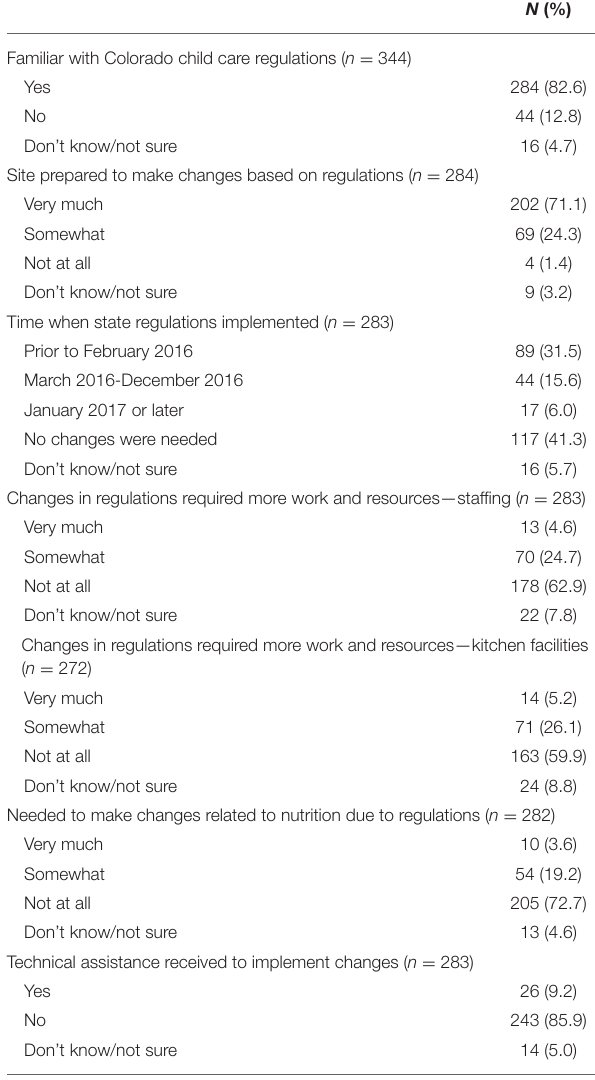
TABLE 4 | Self-reported adherence to regulations related to beverages served in Colorado childcare